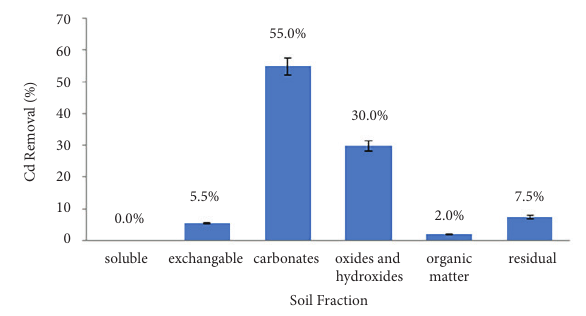
Figure 8. Sequential extraction of cadmium from